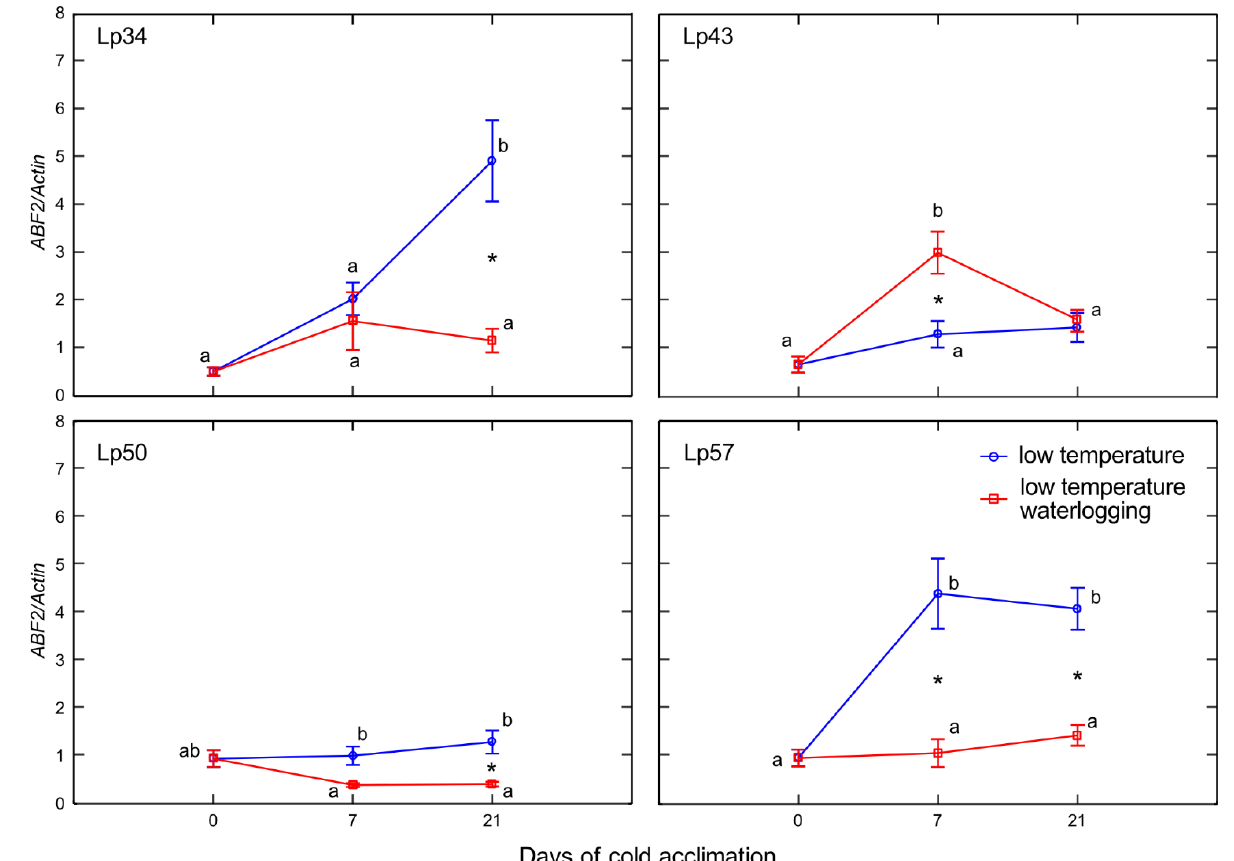
Figure 11. Relative transcript level of ABF 2 of cold-acclimated Lolium perenne genotypes. Four genotypes (Lp34, Lp43, Lp50, and Lp57) were tested. The transcript level was calculated using Actin as a reference gene. The results are means ( n = 4), error bars indicate the standard error. Asterisks indicate means that differ significantly between waterlogged and control plants according to one-way ANOVA ( p < 0.05). Different lower-case letters indicate means that are statistically different according to Duncan’s multiple range test ( p < 0.05).